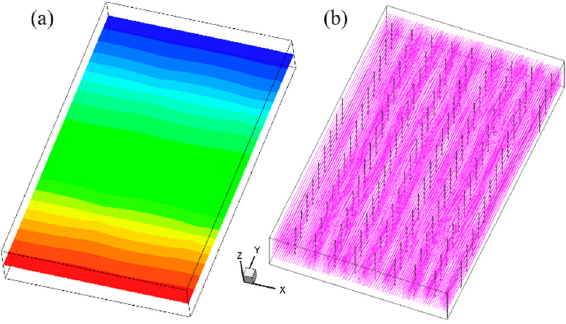
Figure 12. ( a ) Pressure field with a slice through z -axis; ( b ) streamlines.